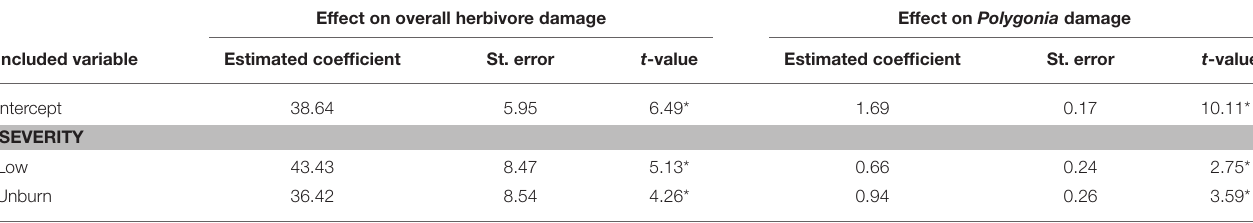
TABLE 3 | Model summary for the effect of fire severity on overall herbivore damage and damage by the butterfly Polygonia gracilis zephyrus to wax currant plants. Effect on overall herbivore damage